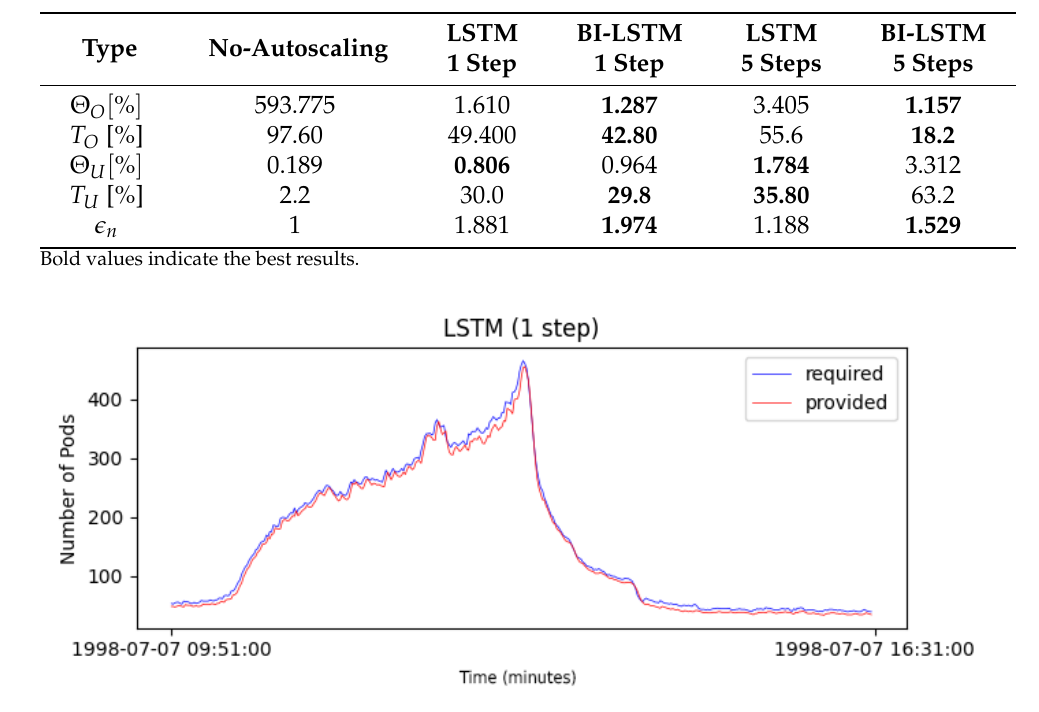
Figure 16. Number of pods produced by the LSTM auto-scaler.